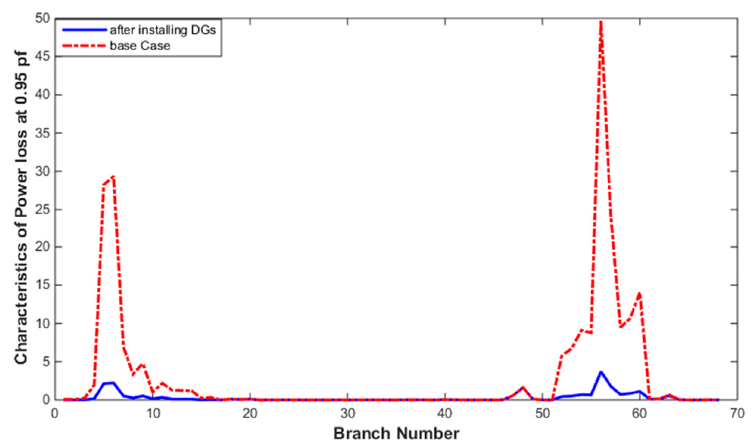
Figure 23. Characteristics of power loss at 0.95 pf.